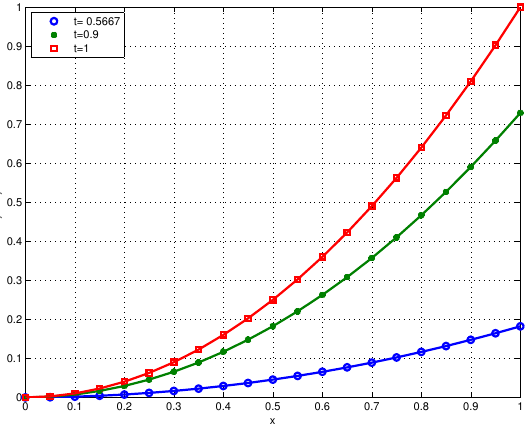
Figure 3. Comparison of the exact and the numerical solutions of the FPDE (24) for α = 0.1 with N = J = 20 at different time steps. Solid lines: exact solution; star, circle and square points: numerical solutions.